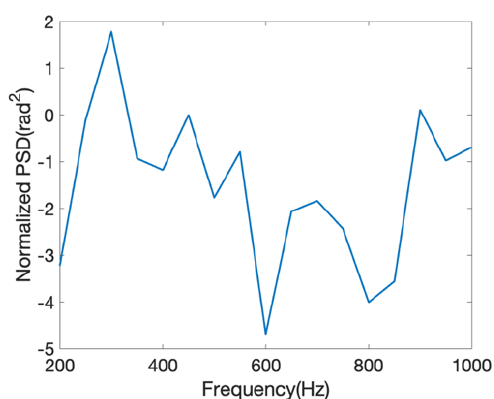
Figure 7. Normalization frequency response of the handmade microphone.